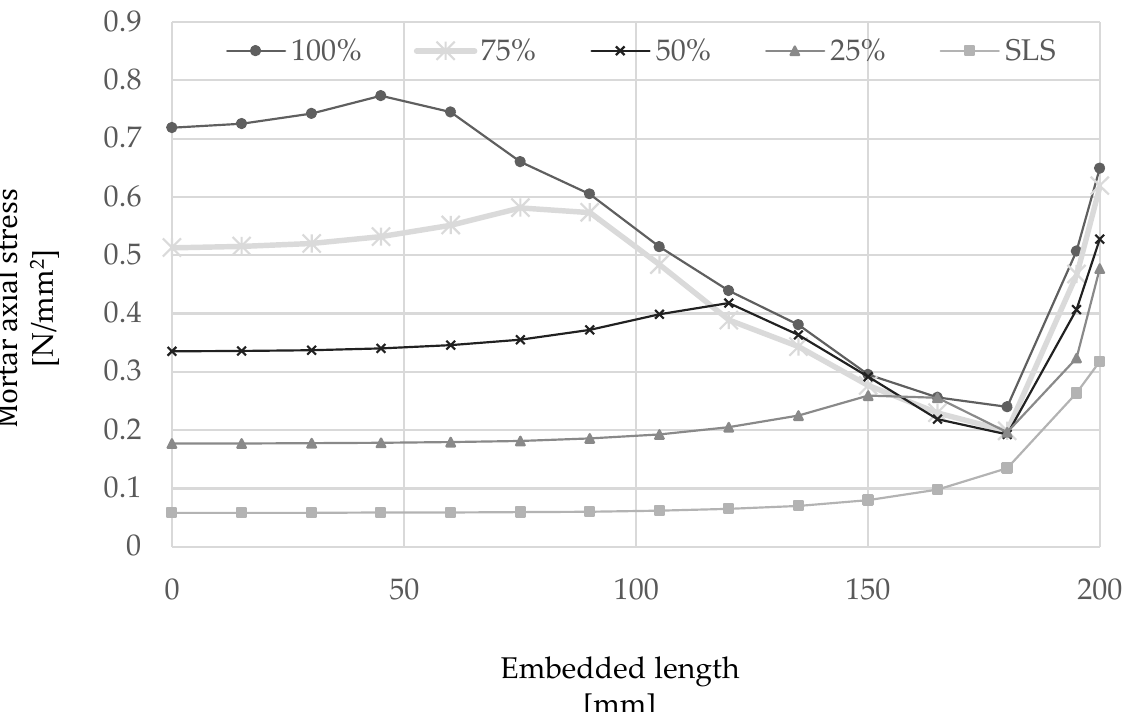
Figure 16. Distribution of axial stress in the mortar along the embedded length of 200 mm at several load levels.